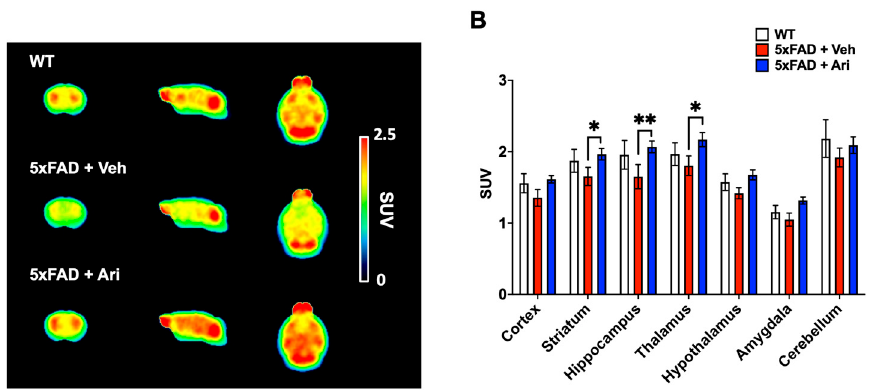
Figure 6. [ 18 F]FDG-PET imaging for evaluating cerebral glucose metabolism following aripiprazole treatment. ( A ) Averaged [ 18 F]FDG PET images between 40 and 60 min after injection in WT controls ( n = 5), 5xFAD + Veh ( n = 6) and 5xFAD + Ari mice ( n = 8). Images are scaled to the SUV. ( B ) Quantification of SUV values for the target regions. Data are presented as mean ± SEM. * p < 0.05 and ** p < 0.01. Table 1. Comparison of the regional SUV values.